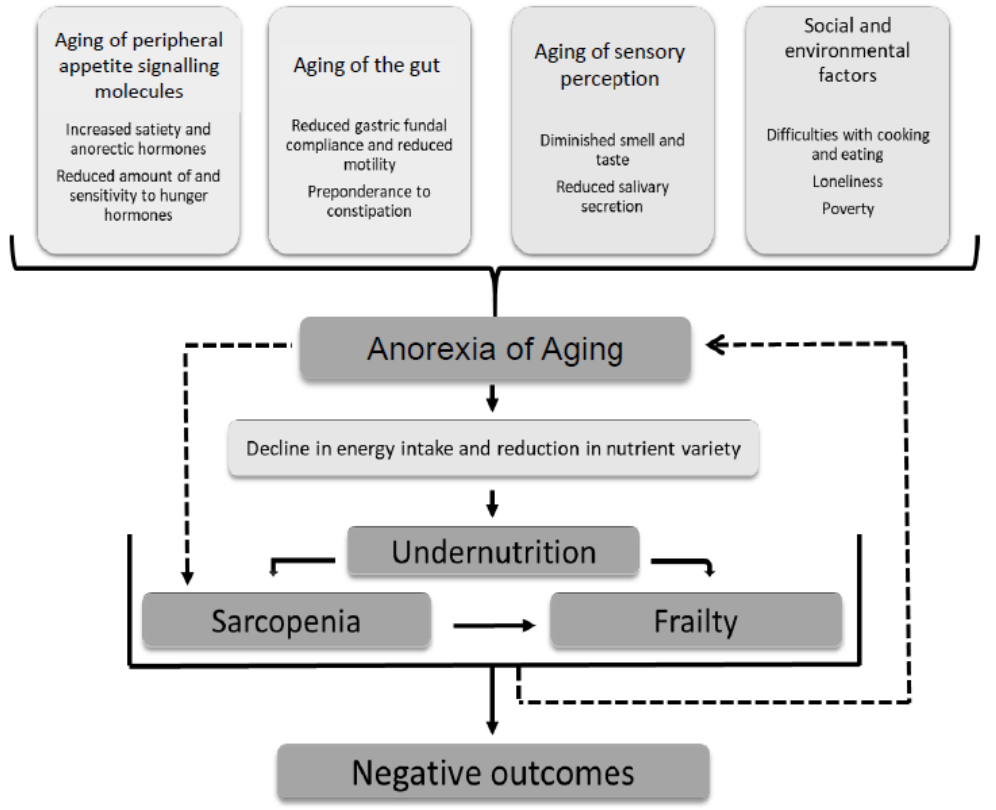
Figure 1. Multi-factorial causes of the anorexia of aging. Consequences are mostly attributable to subsequent undernutrition but there is some evidence for an independent association with sarcopenia [2,8 –